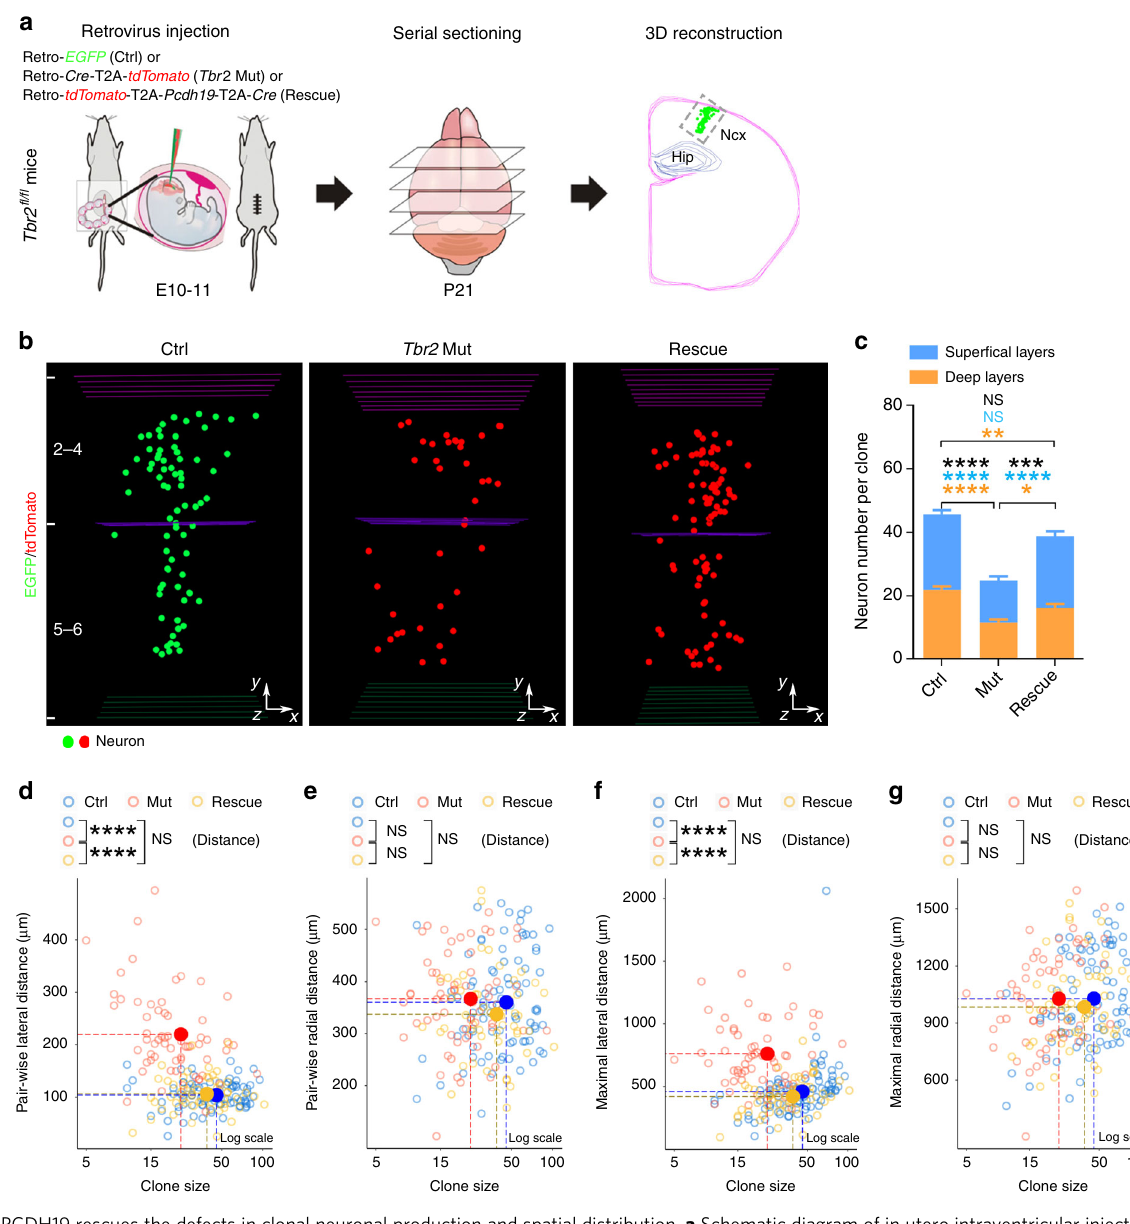
Fig. 6 PCDH19 rescues the defects in clonal neuronal production and spatial distribution. a Schematic diagram of in utero intraventricular injection of low- titer retroviruses expressing EGFP (green, Ctrl), Cre/tdTomato (red, Tbr2 Mut), or tdTomato/PCDH19/Cre (red, Rescue) into the Tbr2 fl / fl mice at E11. Brains were collected at P21 and subjected to serial sectioning and 3D reconstruction to recover individual clones in the cortex. b Representative 3D reconstruction images of control (left, green), Tbr2 Mut (middle, red), and Rescue (right, red) clones. c , Quanti fi cation of the number of neurons in the control ( n = 74), Tbr2 Mut ( n = 62), and Rescue ( n = 53) clones. d – g Quanti fi cation of the pair-wise ( d and e ) and maximal ( f and g ) lateral and radial distances between neurons in control (blue, n = 74), Tbr2 Mut (red, n = 62), and Rescue (yellow, n = 53) clones. Data are presented as mean ± SEM. (* P < 0.05; ** P < 0.01; *** P < 0.001; **** P < 0.0001; NS not signi fi cant; one-way ANOVA followed by Tukey ’ s